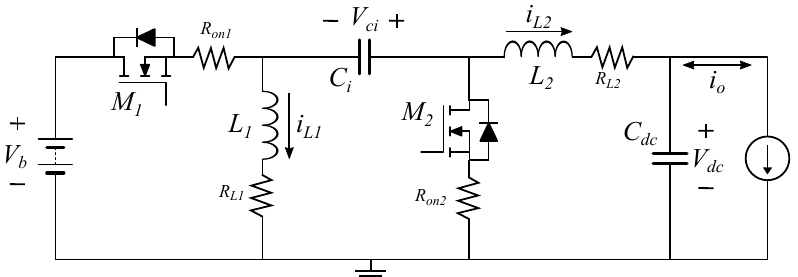
Figure 2. Charger/discharger circuit including parasitic